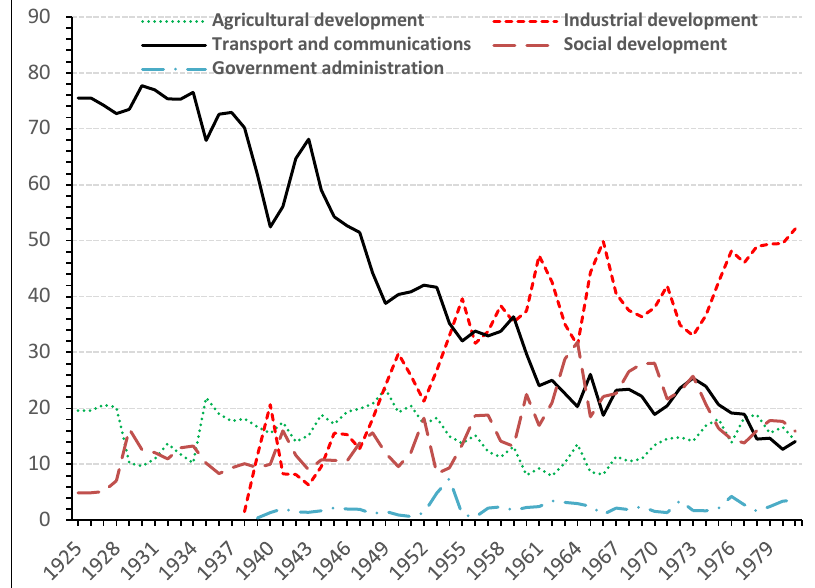
Source: Own estimates with information from